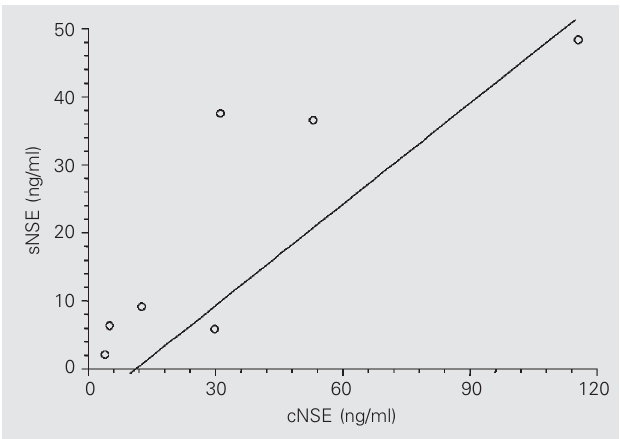
Figure 3. Nonparametric linear regression analysis of neuron-specific eno- lase levels in serum (sNSE) and neuron-specific enolase levels in cere- brospinal fluid (cNSE) of the encephalic (ENC) group (N = 7). P = 0.035 (Kendall’s rank correlation coefficient tau b =